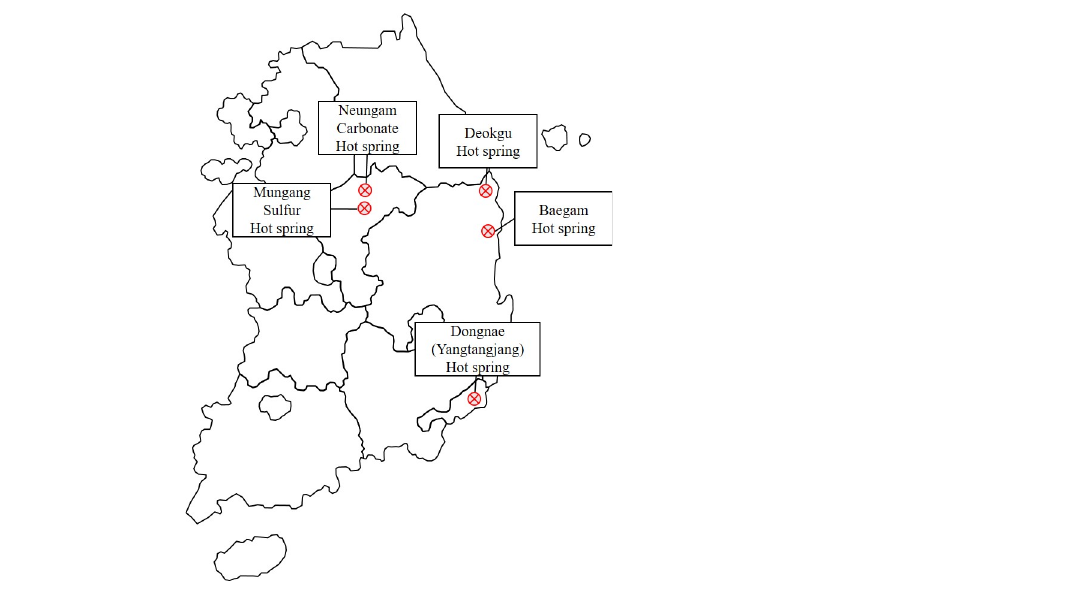
Figure 1. Map of the hot spring area in Korea where the samples were collected for this study. Neungam and Mungang hot springs are located in Chungju, Deokgu and Baegam hot springs are located in Uljin, and Dongnae (Yangtangjang) hot spring is located in Busan, respectively. Table 1. Hot spring properties.